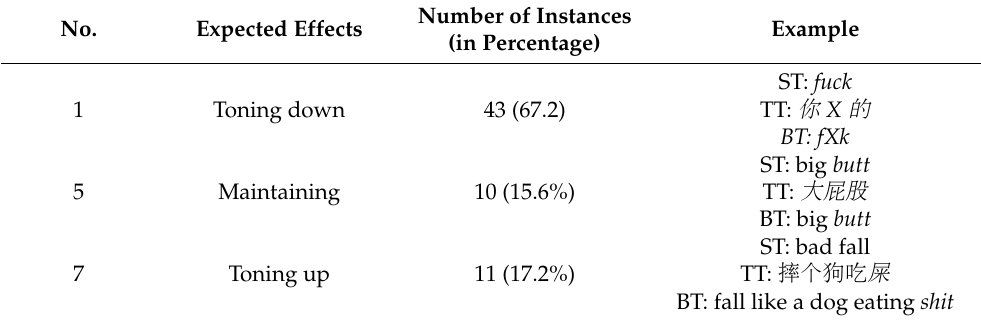
Table 5. Results